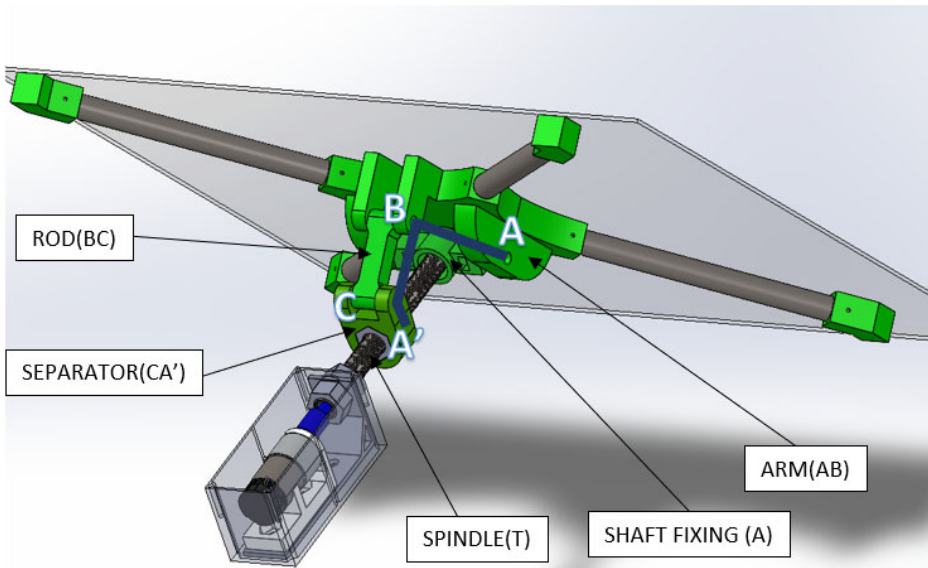
Figure 8. Deformable polygon for the proposed heliostatic illuminator.